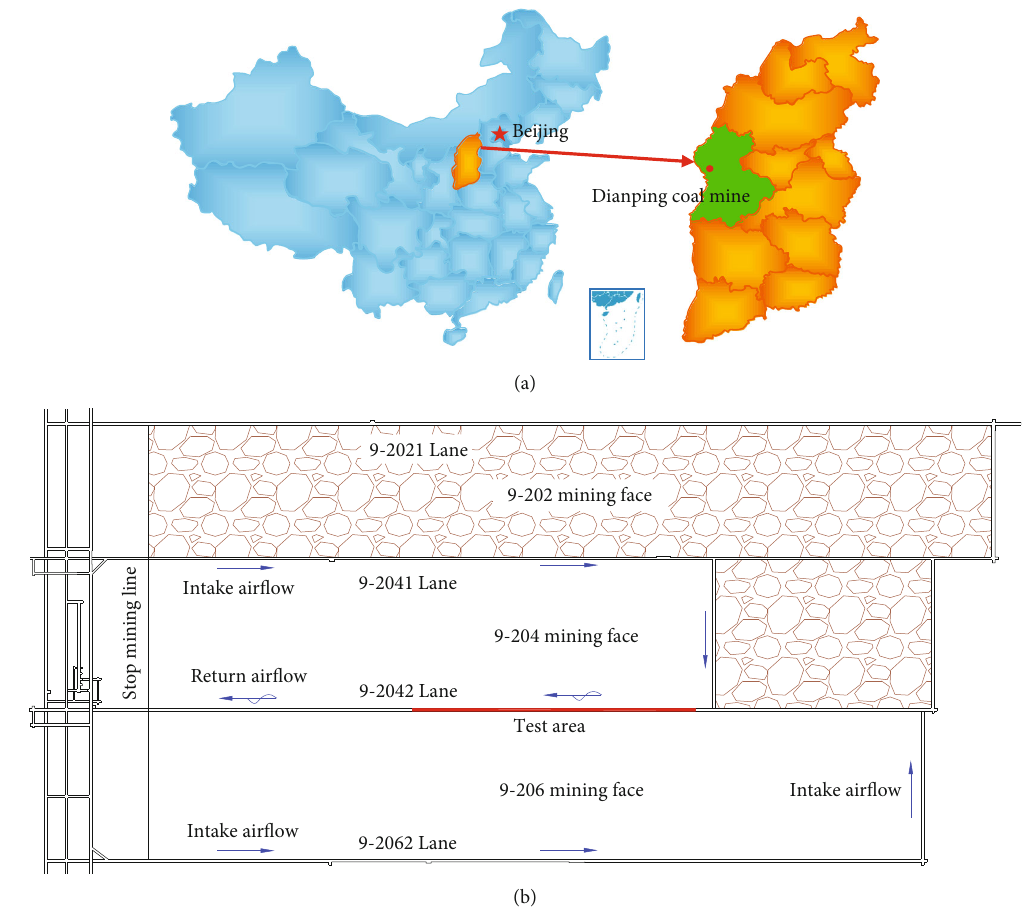
Figure 3: Test site (Dianping Coal Mine): (a) location in China and (b) 9-2042